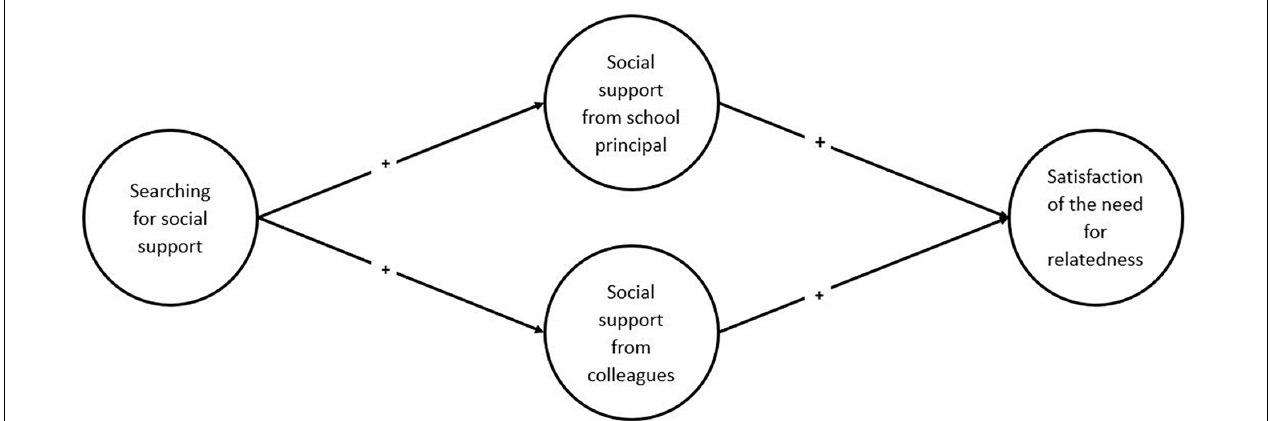
FIGURE 1 | Conceptual research